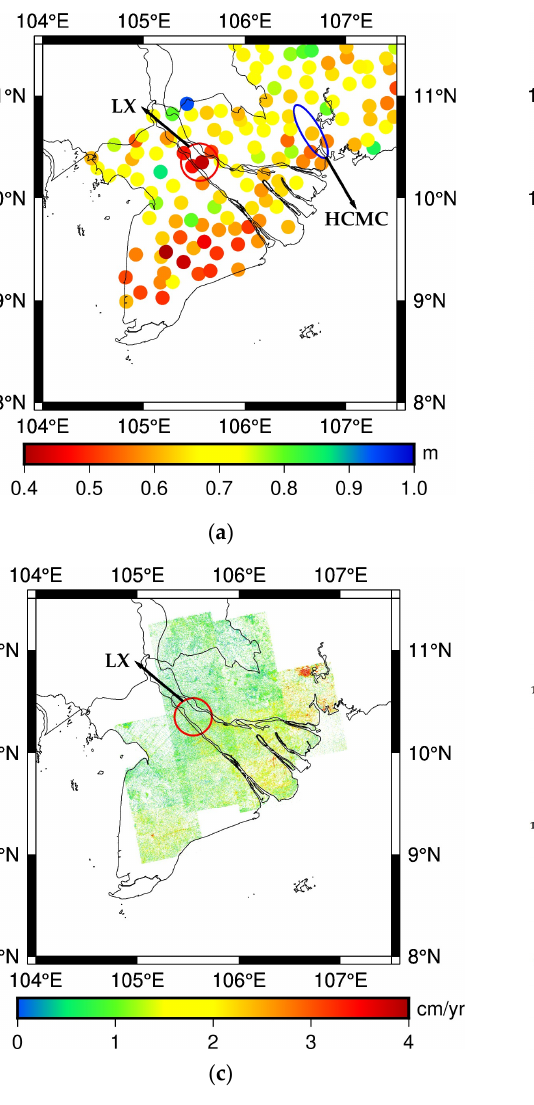
Figure 6. ( a ) Differences of GNSS/levelling data and GEOID_LSC in the southern region; ( b ) Linear regression on the differences of GEOID_LSC and GNSS/levelling data in the southern region; ( c ) InSAR results derived for the period 2006–2010 from ALOS-1 provided by Dr Laura E Erban [20] and ( d ) InSAR results derived for the period 2015–2018 from Sentinel-1, project EMSN057 [41]. The 683 GNSS/levelling points with latitudes greater than 11° are considered to be unaffected by subsidence. The height anomalies of these GNSS/levelling points were compared with those derived from the GEOID_LSC in the absolute sense. The results are listed in Table 4. Aiming for GNSS/levelling data of the same precision in the southern part (<11° in latitude), we corrected the data using the annual subsidence rate grid calculated with ALOS-1. To avoid affecting the edge, the remaining grid nodes (not calculated by ALOS-1) were set to zero. Height anomalies of 47 points were corrected considering a 7 year lag between levelling and GNSS measurement periods. On the height anomalies of GNSS/levelling points ( ζ GNSS/levelling ), we performed the correction according to the following formula: (cid:2014) (cid:1833)(cid:1840)(cid:1845)(cid:1845)/(cid:1864)(cid:1857)(cid:1874)(cid:1857)(cid:1864)(cid:1864)(cid:1861)(cid:1866)(cid:1859)_(cid:1855)(cid:1867)(cid:1870) = (cid:2014) (cid:1833)(cid:1840)(cid:1845)(cid:1845)/(cid:1864)(cid:1857)(cid:1874)(cid:1857)(cid:1864)(cid:1864)(cid:1861)(cid:1866)(cid:1859) + (cid:1872). (cid:1848) where V is the annual average subsidence rate of the GNSS/levelling point interpolated from the rate